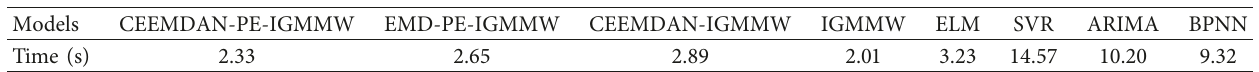
Table 6: Comparison of computing time of eight models in degradation tendency